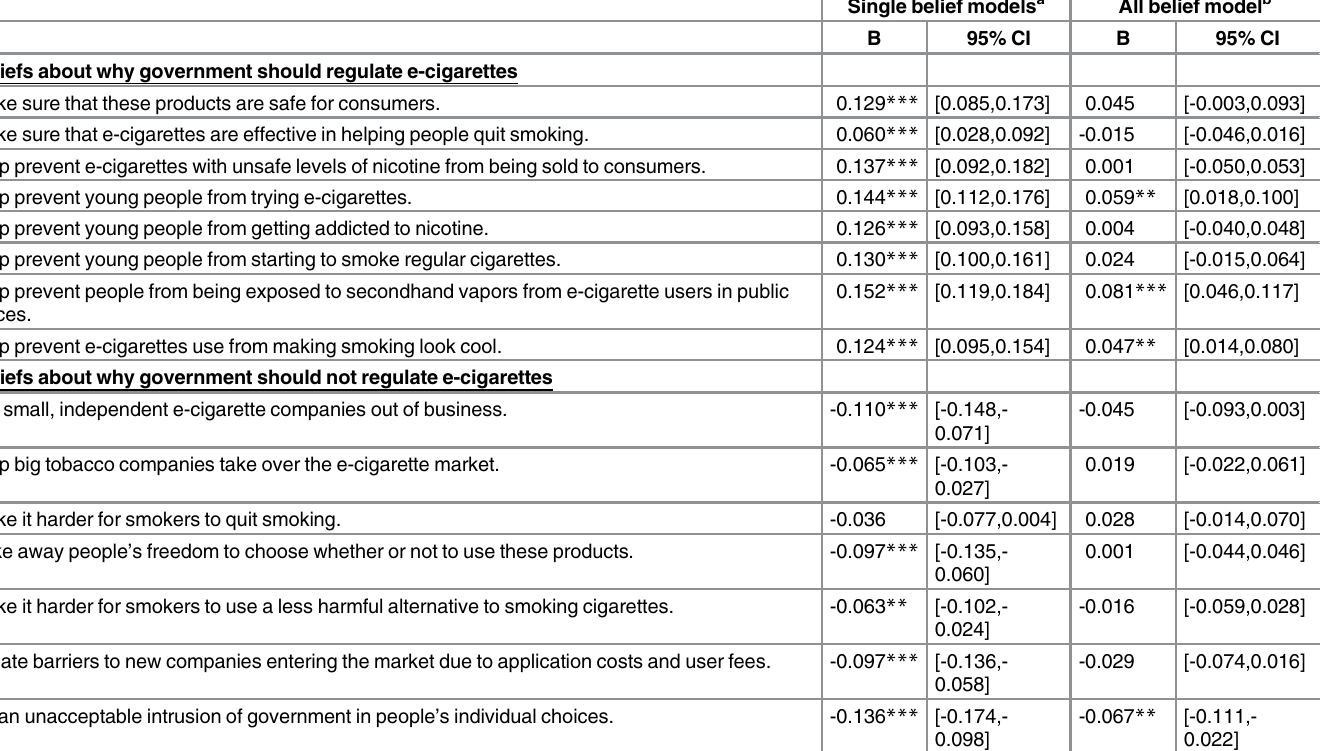
Table 3. Adjusted regression analyses predicting policy support scale with pro-regulation beliefs (why government should regulate) and anti-reg- ulation beliefs (why government should not